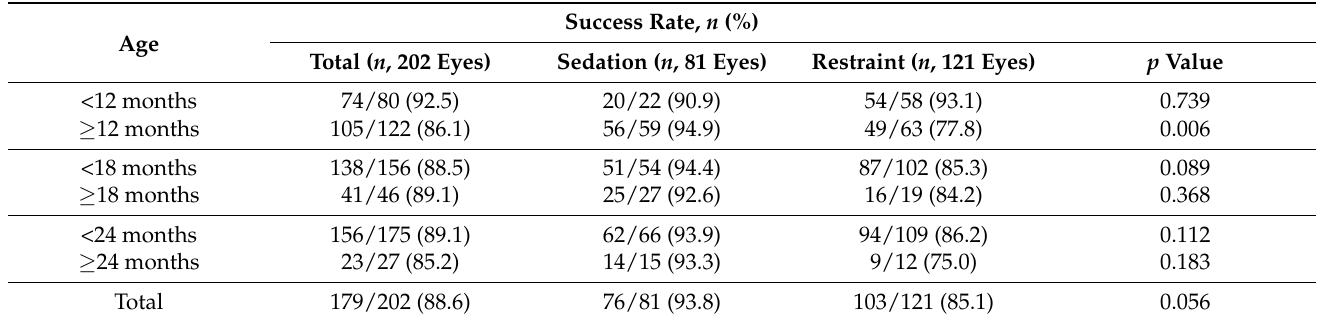
Table 2. Success rates of office probings by age of months.